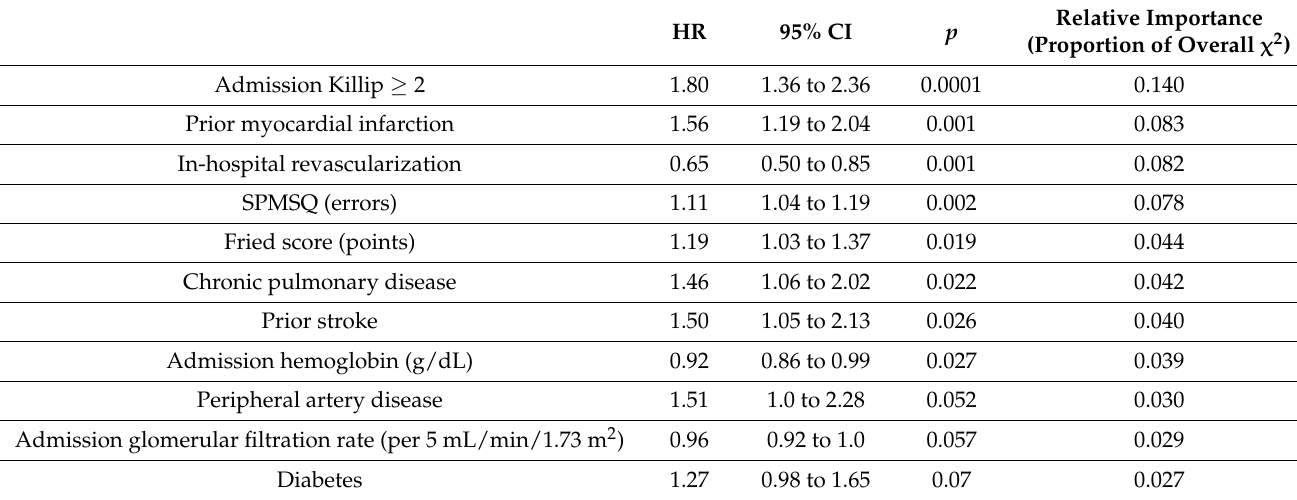
Table 4. Multivariable model for death or acute myocardial infarction (total number of events =